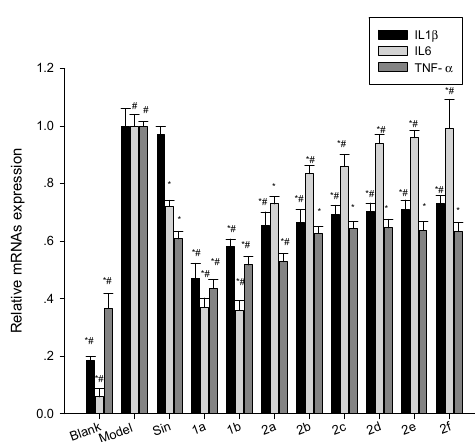
Figure 6. Effect of Sin and 1a – 2f on the LPS-induced mRNA expression of the inflammatory factors IL1 β , IL6, and TNF- α in Raw264.7 cells. Raw264.7 cells were treated concurrently with 1 µ g/mL of LPS (blank was untreated) and 10 µ g/mL of Sin or 1a – 2f for 12 h. The cells were washed, the mRNA was extracted using Trizol, and the mRNA expression was determined using RT-PCR. In general, the derivatives enhanced the Sin induced IL1 β and TNF- α inhibition, while reducing the IL6 inhibition. Results are expressed as mean ± SD ( n = 3). * p < 0.05 vs. vehicle (model group); # p < 0.05 vs. Sin.